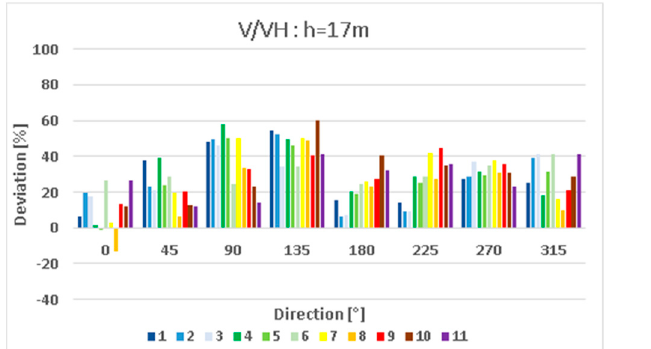
the 11 probe validation points at height h = 12 m with WAsP Engineering.